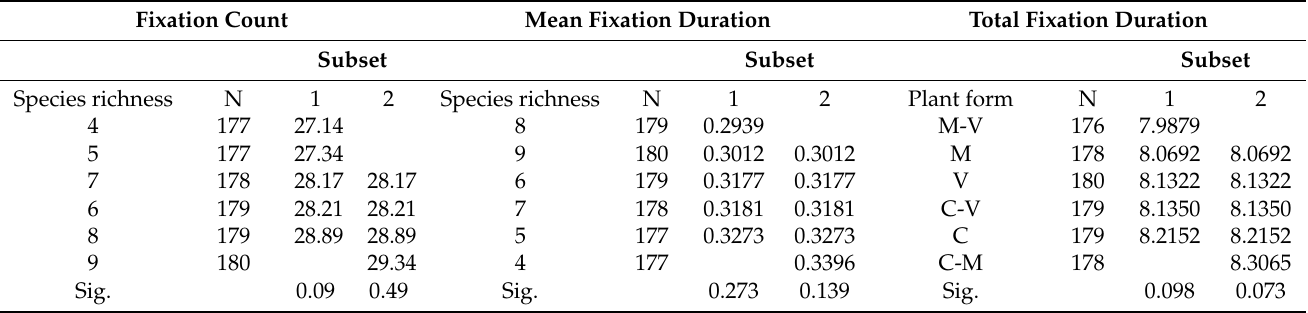
Table 3. Differences of gaze behavior in vegetation landscape composed of plants of different forms and species richness.